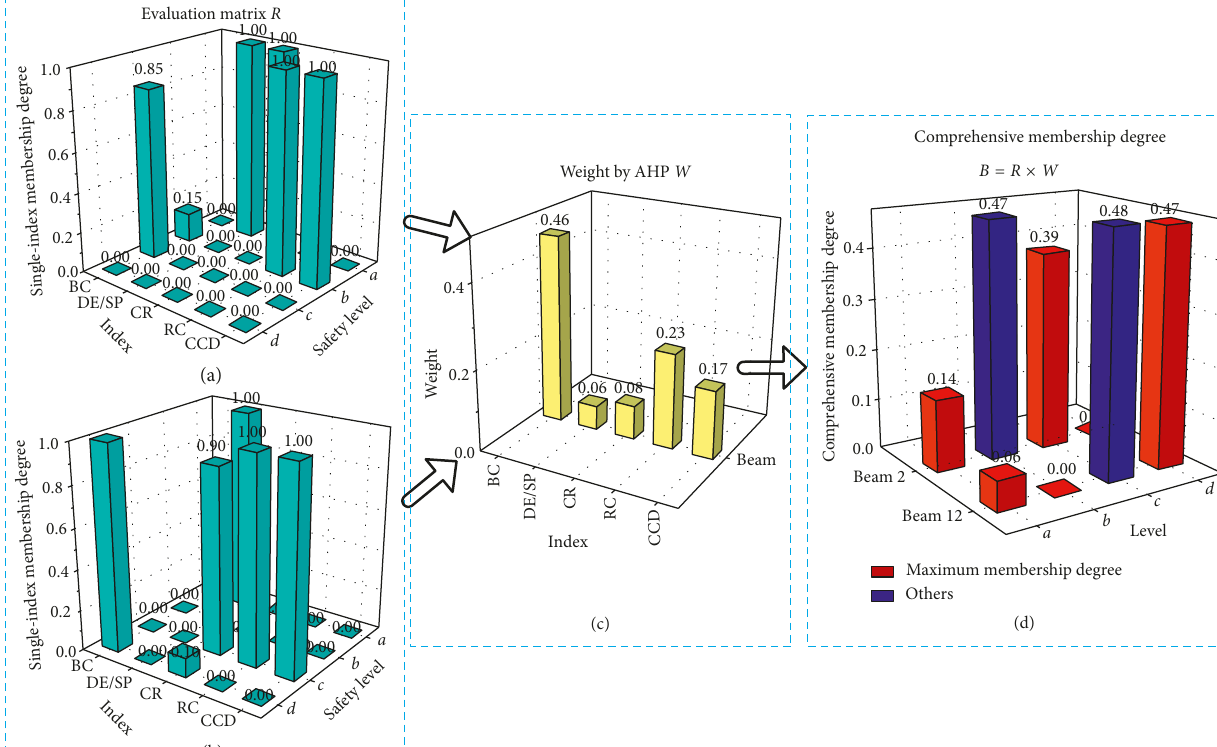
Figure 6: AHP-Fuzzy comprehensive evaluation results. (a, b): The plane axes represent the safety level and index, respectively; the vertical axis represents the single index membership degree; the column height represents the value of the membership degree of each index for each safety level. (c) The yellow column height represents the weight value of each index calculated by AHP. (d): The plane axes represent the safety level and the safety appraisal objects (beams 2 and 12); the vertical axis represents the comprehensive membership degree of each safety level; the blue column represents the maximum membership degree of beams 2 and 12, and the red columns represent other membership degrees. Relationship: the weight (i.e., (c)) integrates the single index membership degree (i.e., (a) and (b)) into the comprehensive membership degree (i.e., (d)). BC: bearing capacity; DE/SP, deflection/span; CR, cracks; RC, reinforcement corrosion; CCD, concrete carbonation depth; AHP, analytic hierarchy